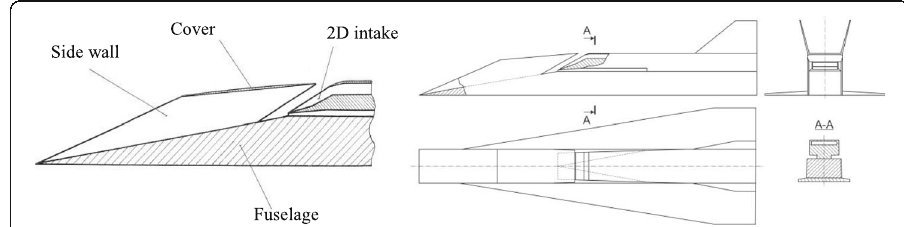
Fig. 7 Configuration of vehicle based on Busemann biplane concept: the nose part (left) and the sketch of the wind-tunnel model (right)